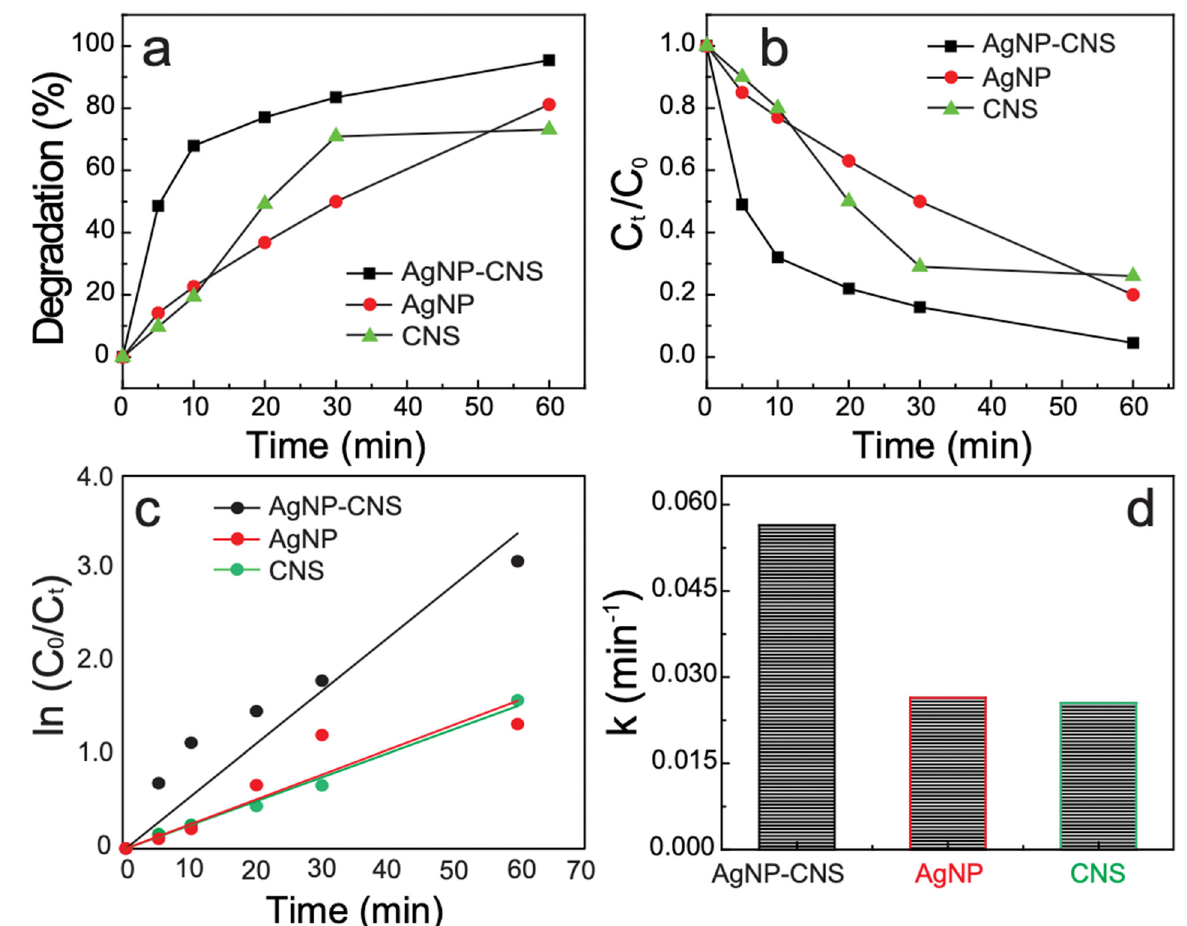
Figure 7. Photocatalytic performance toward MB dye decomposition in the presence of the AgNP– CNS nanocomposite, AgNPs, and CNSs under UV light: ( a ) degradation percentage of MB dye, ( b ) photocatalytic performance, as represented by the variation of C t / C 0 with time, ( c ) the corresponding kinetic plots for dye degradation, and ( d ) the rate constants for the AgNP–CNS nanocomposite, AgNPs, and CNSs.